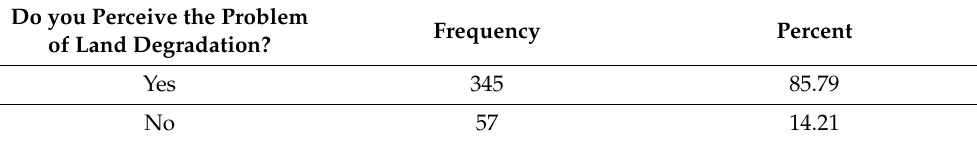
Table 4. Perception of land